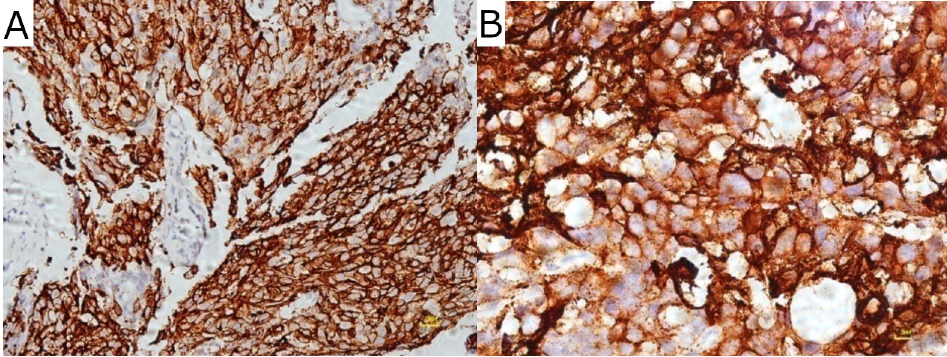
Fig 4. Immuno-histochemical expression of COX -2in esophageal squamous cell carcinoma. Staining (membranous & cytoplasmic) (A) at low power magnification (10x). (B) at high power magnification [40x].